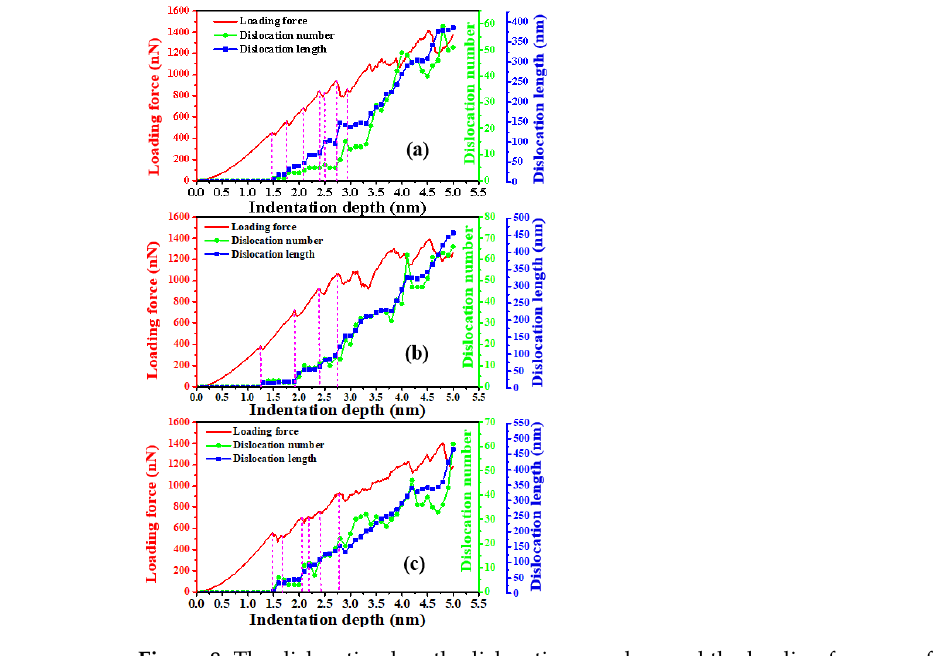
Figure 8. The dislocation length, dislocation number, and the loading force as a function of indentation depth: ( a ) (001) plane, ( b ) (110) plane and ( c ) (111) plane.